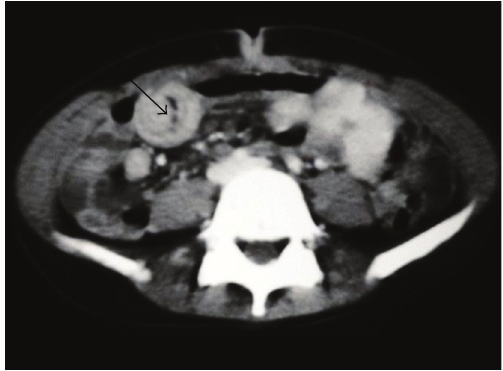
Figure 4: Tomography image of bowel invagination